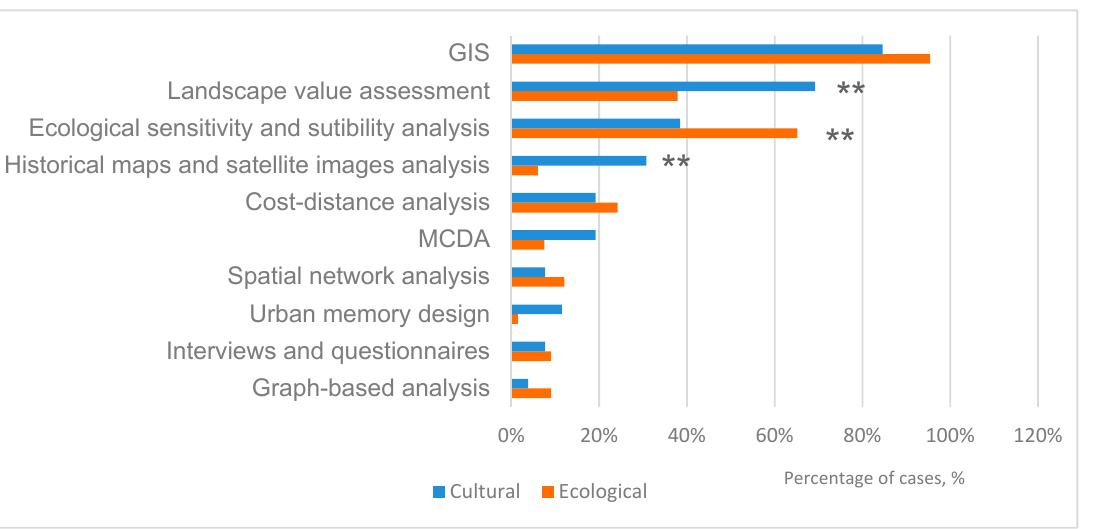
Figure 6. Variation in approaches used in cultural and ecological landscape corridor analysis. The asterisks indicate the significance level: ** means p ≤ 0.01. MCDA, multi-criteria decision analysis; GIS, Geographical Information System.